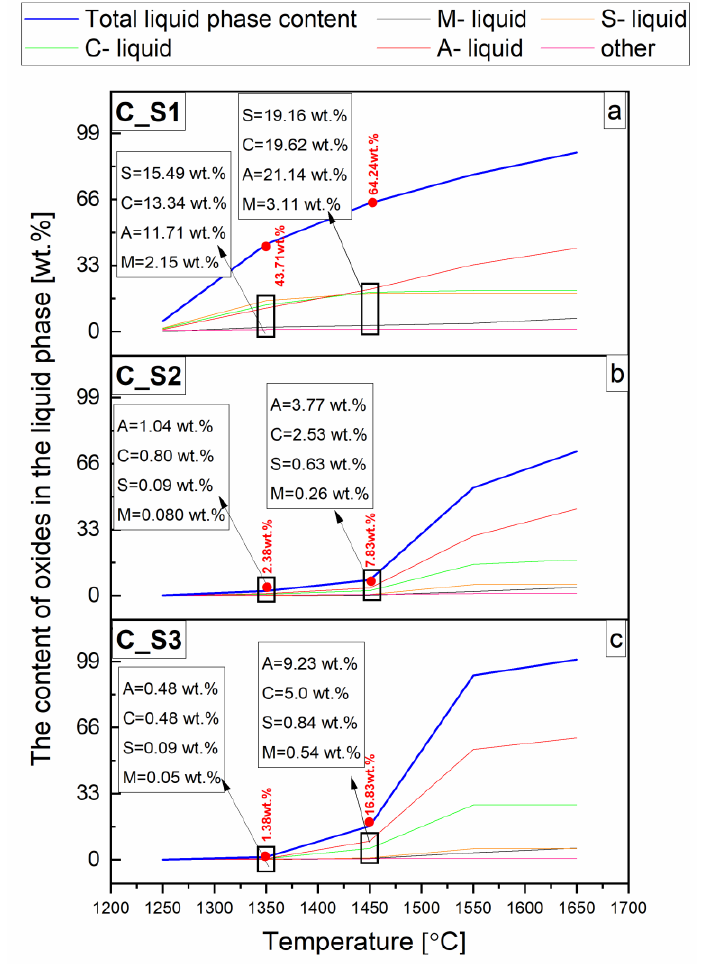
Figure 6. Liquid vs. temp. content and chemical compositions of the liquid phase from FactSage calculation in wt.% of the reactive mixtures containing components of the cement-free corundum- spinel refractory castable with 7 wt.% of MgO (castable C) and steel slags with the C/S mass ratio of 1.1 ( a ), 3.5 ( b ), 5.5 ( c ). Table 2. Temperature of the onset of the appearance of the liquid